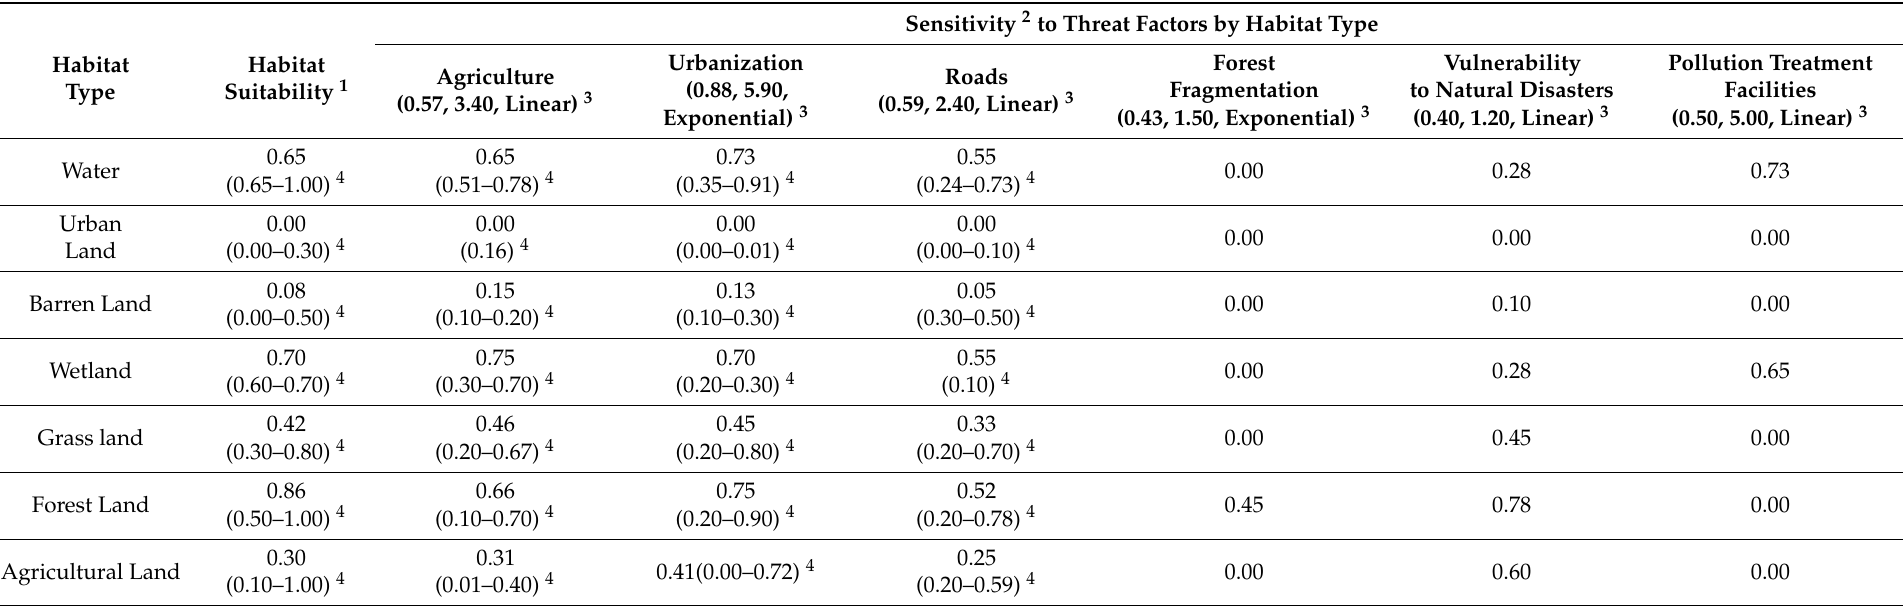
Table 1. Habitat suitability and habitat sensitivity to threat factors on Jeju, South